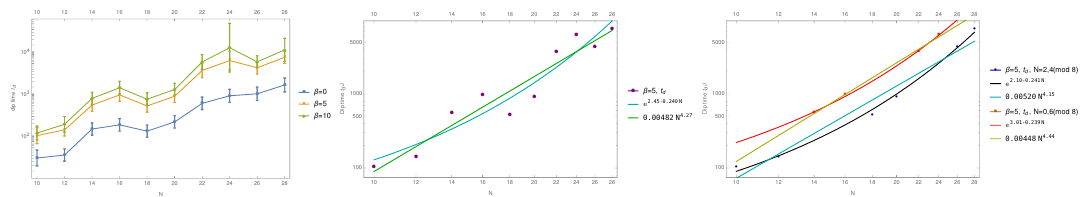
Figure 7 . The dip time t d for supersymmetric SYK model. In the left (cid:12)gure, we evaluate three di(cid:11)erent temperatures and compute the dip time with respect to N , where the error bar is given as the standard deviation when evaluating t d because of large noise is around the minimal point of g ( t ). In the middle (cid:12)gure we (cid:12)t the dip time by polynomials and exponential functions for t d ( N ) at the temperature (cid:12) = 5. In the right (cid:12)gure we separately (cid:12)t the dip time for two di(cid:11)erent random matrix classes with the same temperature (cid:12) = 5 and the same (cid:12)tting functions.